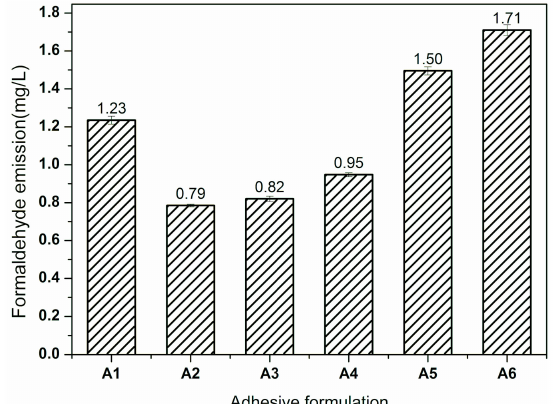
Figure 2. The formaldehyde emission of the plywood bonded by UF resin with di ff erent fillers: Resin A1—0% SEP + 100% WF, Resin A2—20% SEP + 80% WF, Resin A3—40% SEP + 60% WF, Resin A4—60% SEP + 40% WF, Resin A5—80% SEP + 20% WF, Resin A6—100% SEP + 0%WF. Error bars represent standard deviations from three